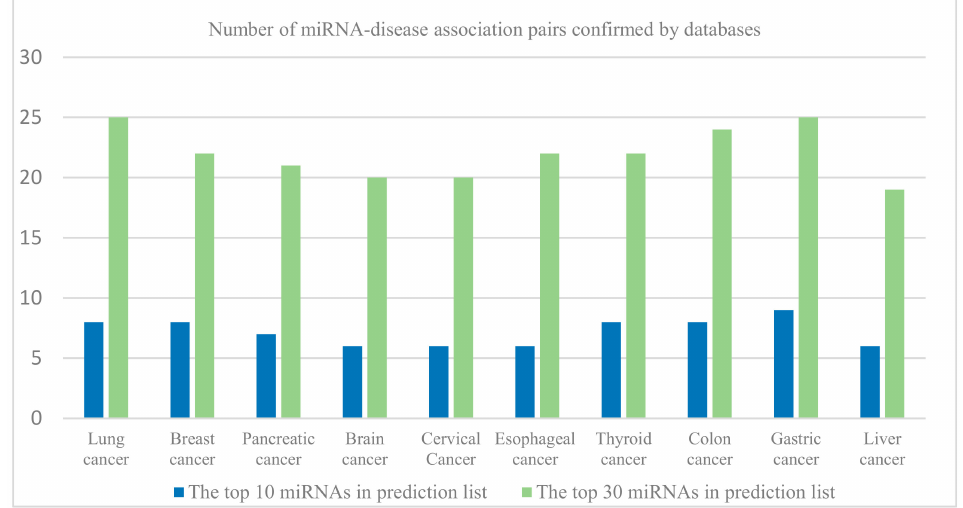
Figure 3. Number of top 10 and top 30 miRNA-disease association pairs of 10 cancers confirmed by